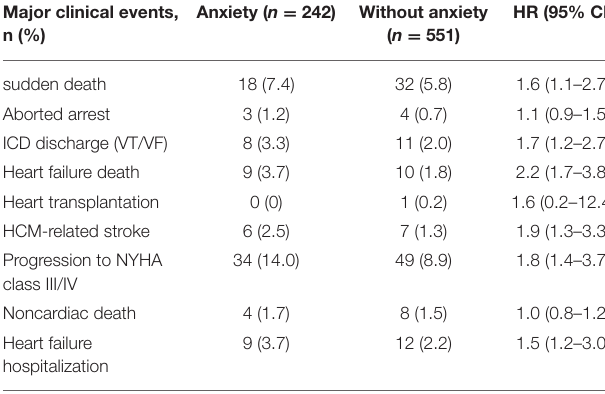
TABLE 2 | Major clinical events of the study participants during follow-up. Major clinical events, n (%)